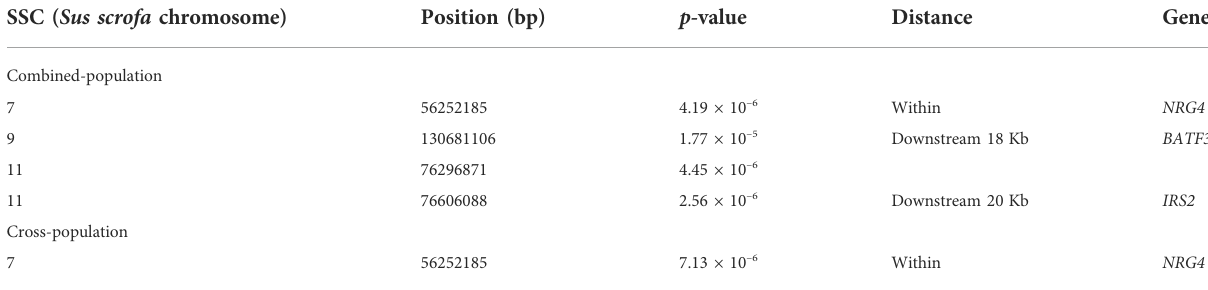
TABLE 2 Signi fi cant SNPs and genes in which they are located identi fi ed in the genome-wide association study for AGE100 trait. SSC ( Sus scrofa